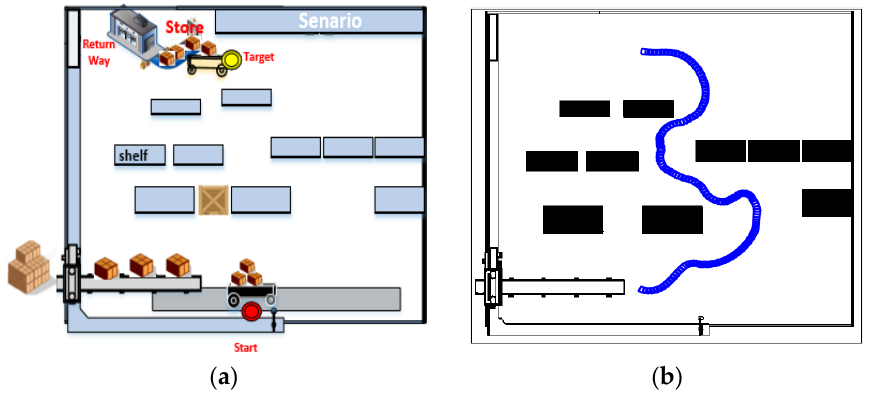
Figure 11. ( a , b ) Task and path planning of the mobile robot.